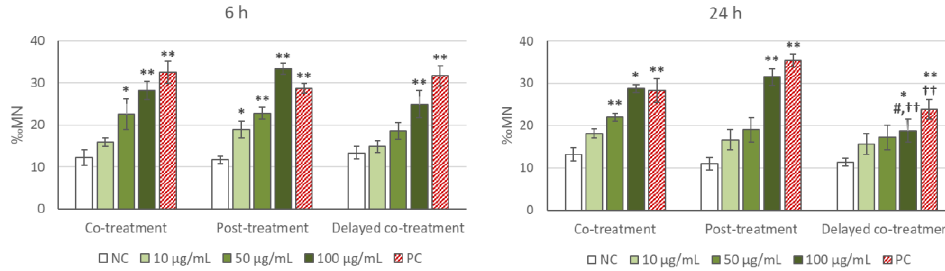
Figure 4. Results of the CBMN test in SH-SY5Y cells treated with TiO 2 NP for 6 h ( left ) or 24 h ( right ) following three different treatment options: co-treatment, post-treatment, and delayed co-treatment (see Figure 1 for details). Error bars represent mean standard error. * p < 0.05; ** p < 0.01, significant difference with regard to the corresponding negative control (NC); # p < 0.05, significant difference with regard to 100 µg/mL co-treatment; †† p < 0.01, significant difference with regard to the corre- sponding post-treatment dose. PC: positive control (MMC: 10 µM for 6 h and 1.5 µM for 24 h treat- ments).